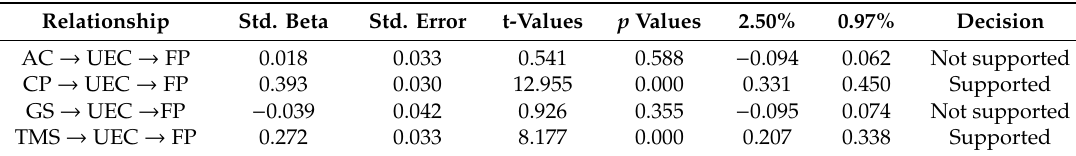
Table 11. Mediation